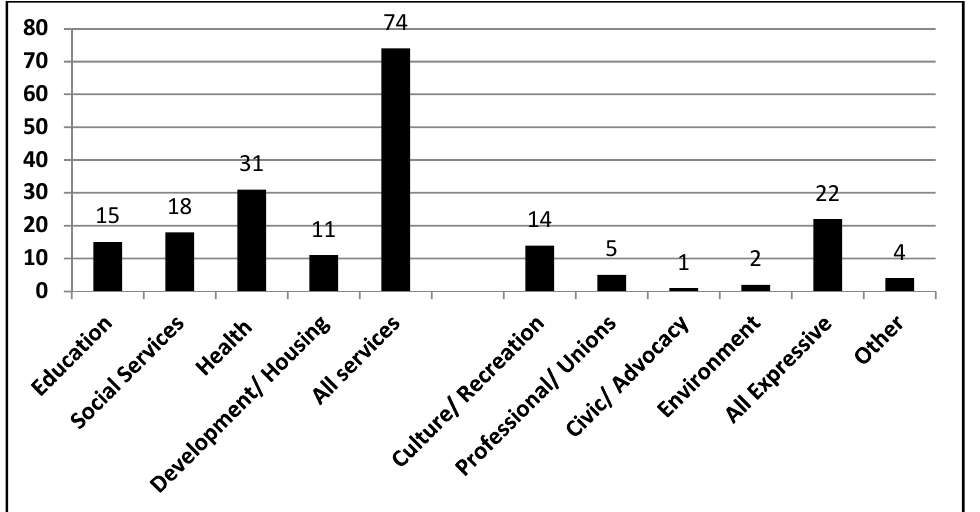
Figure 2: Percent of Total Nonprofit and Voluntary Sector Workforce (Canada) Because seventy-five percent of nonprofit organizations in Canada are focused on the delivery of education, health, social service,